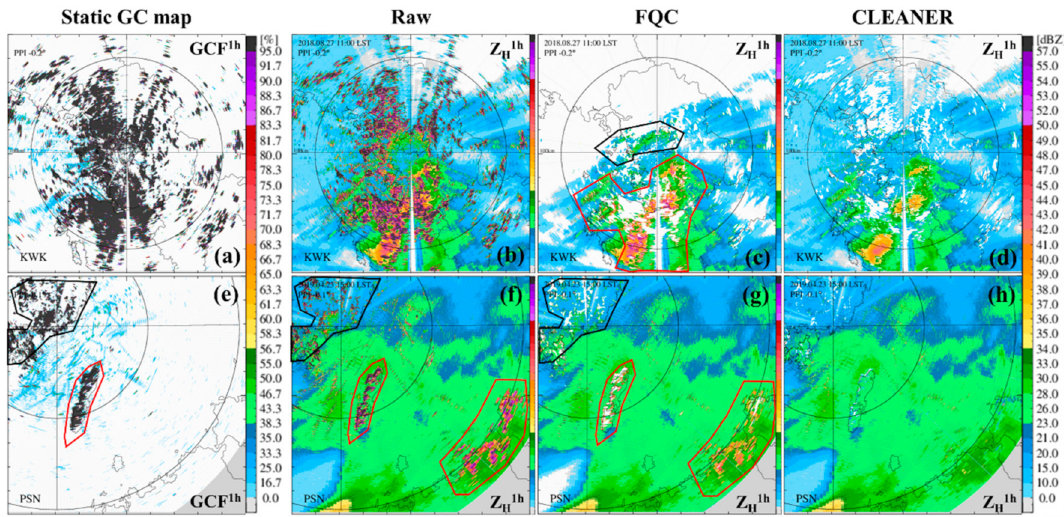
Figure 8. ( a , e ) The static GC map ( GCF ) and 1-h mean reflectivity fields before and after applying quality control (QC) algorithms. ( b – d ) The case with large-clustered GC of KWK at an elevation angle of –0.2 ◦ from 1100 to 1155 LST 27 August 2020. ( f – h ) Super-refraction case of PSN at an elevation angle of 0.1 ◦ from 1500 to 1555 LST 23 April